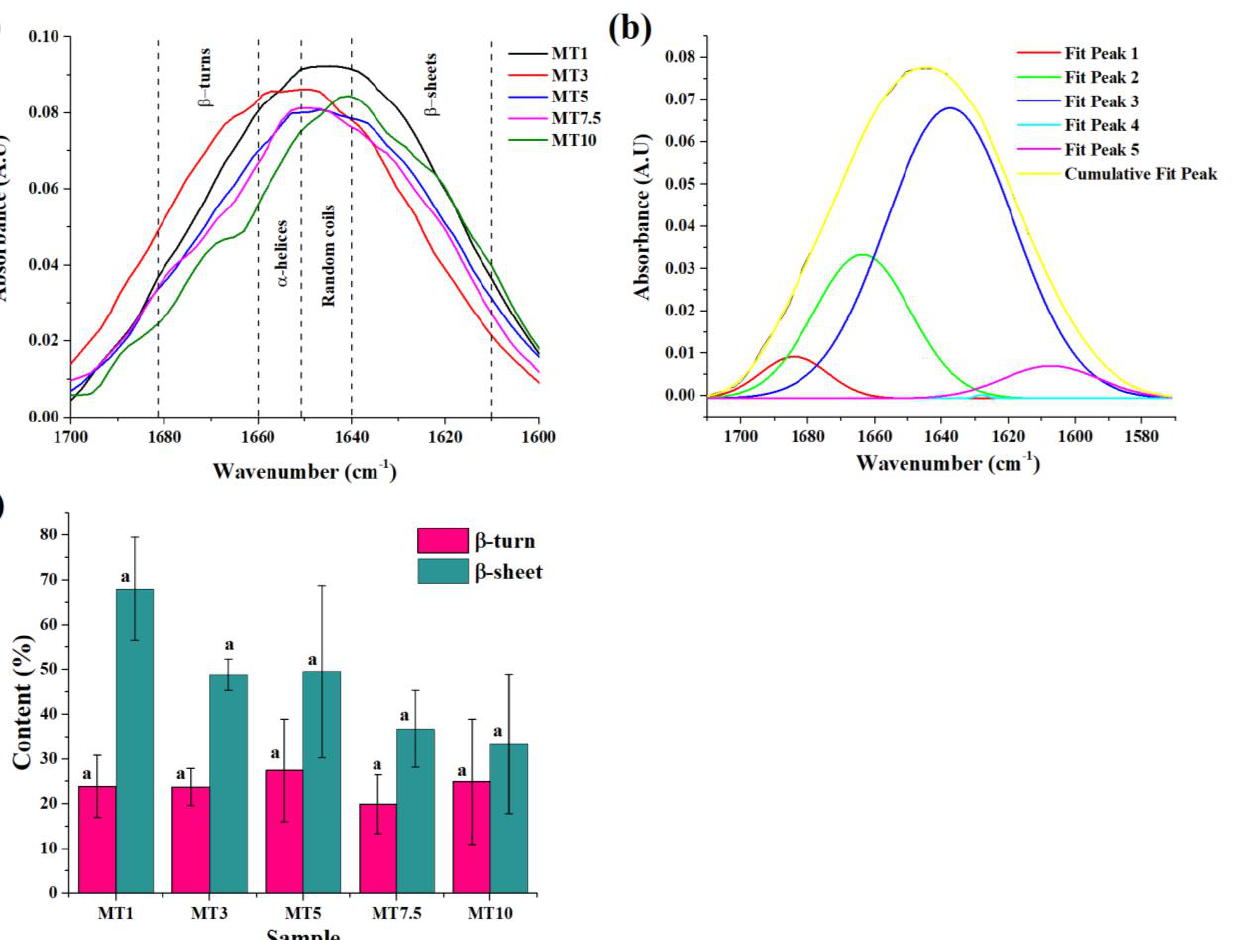
(Figure 8a,b). Bands at about 1000–995 cm − 1 are related to hydrated crystalline samples,